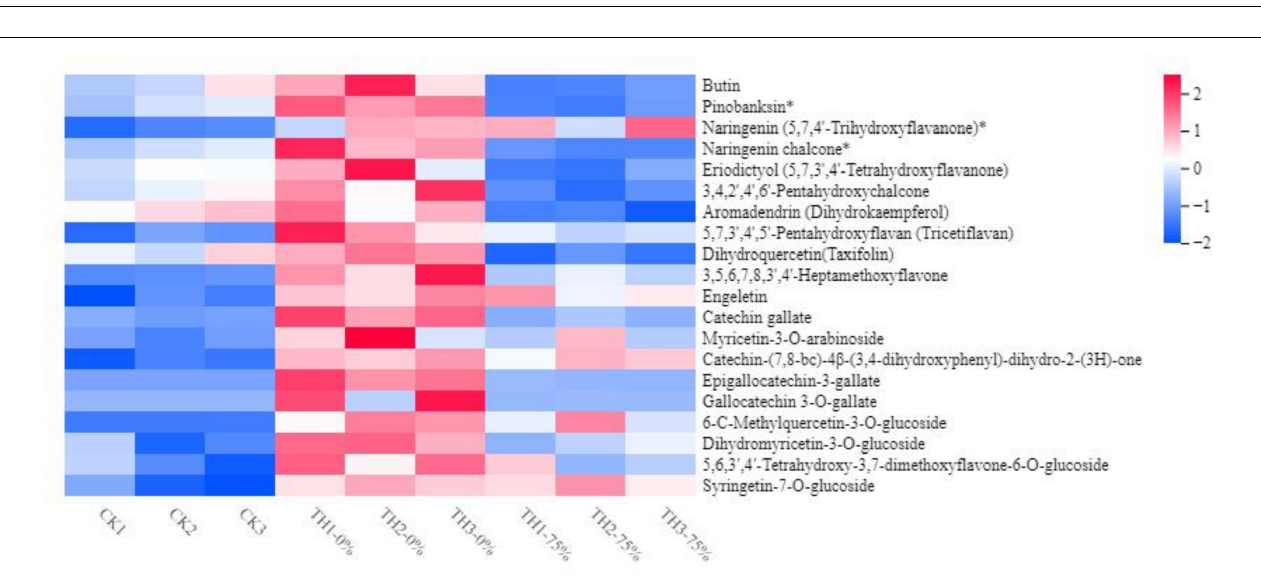
FIGURE 4 | Heat map visualization of metabolites. The content of each flavonoid metabolite was normalized. Each sample is visualized in a single column, and each metabolite is represented by a single row. Red indicates high abundance, whereas low relative metabolites are shown in blue (the color key scale is provided on the right of the heatmap). The symbol ∗ indicates that isomers of the metabolite, but specific isomers cannot be